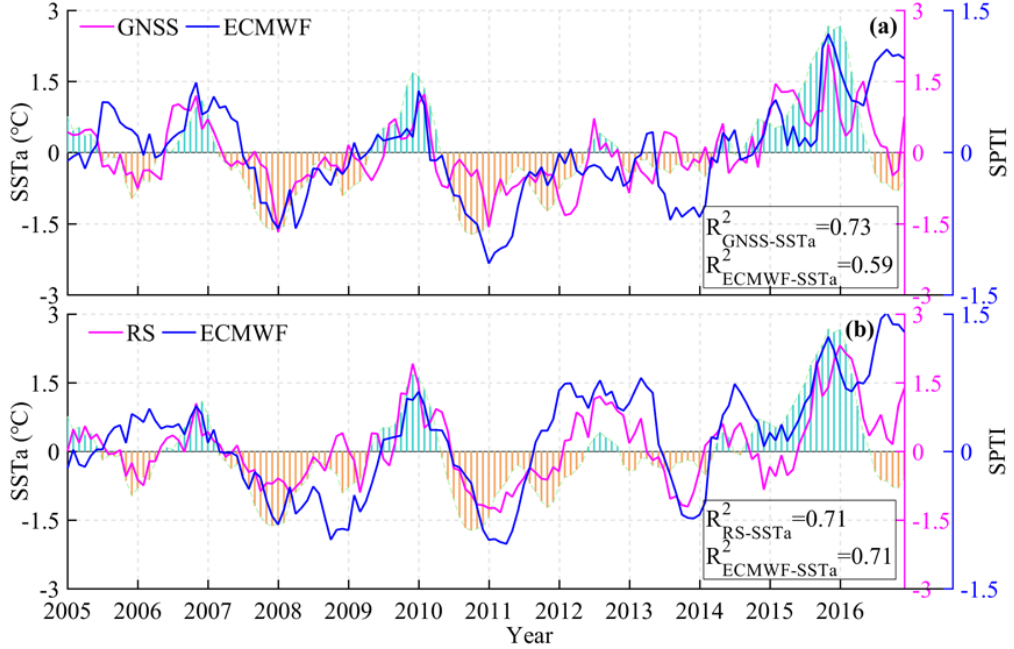
Figure 10. Time series of month SPTI calculated using ERA-Interim, GNSS, and RS data with SSTA at GNSS and RS stations (WUHN and 45004, respectively) over the period of 2005 – 2016.